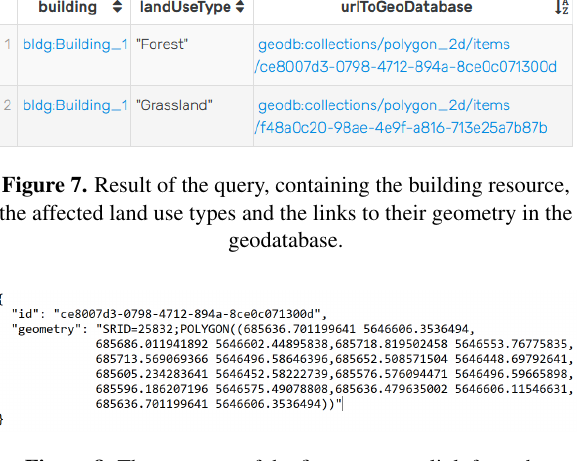
Figure 8. The response of the first geometry link from the SPARQL query as WKT string together with id in JSON format. This example shows, that the hybrid approach can be success- fully applied for BIM-GIS